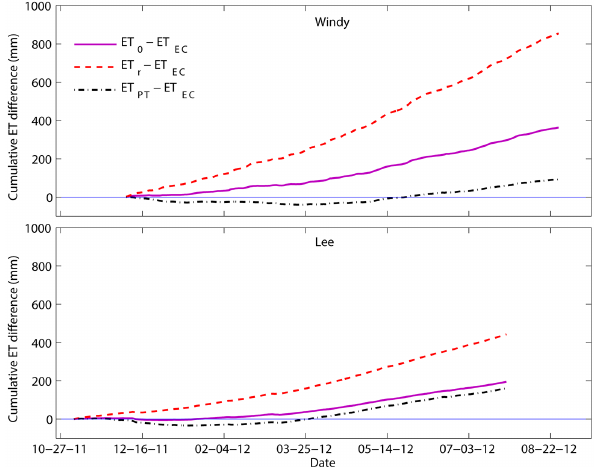
Figure 6. Cumulative difference between reference and measured ET since the beginning of the mid-period in each EC tower field.